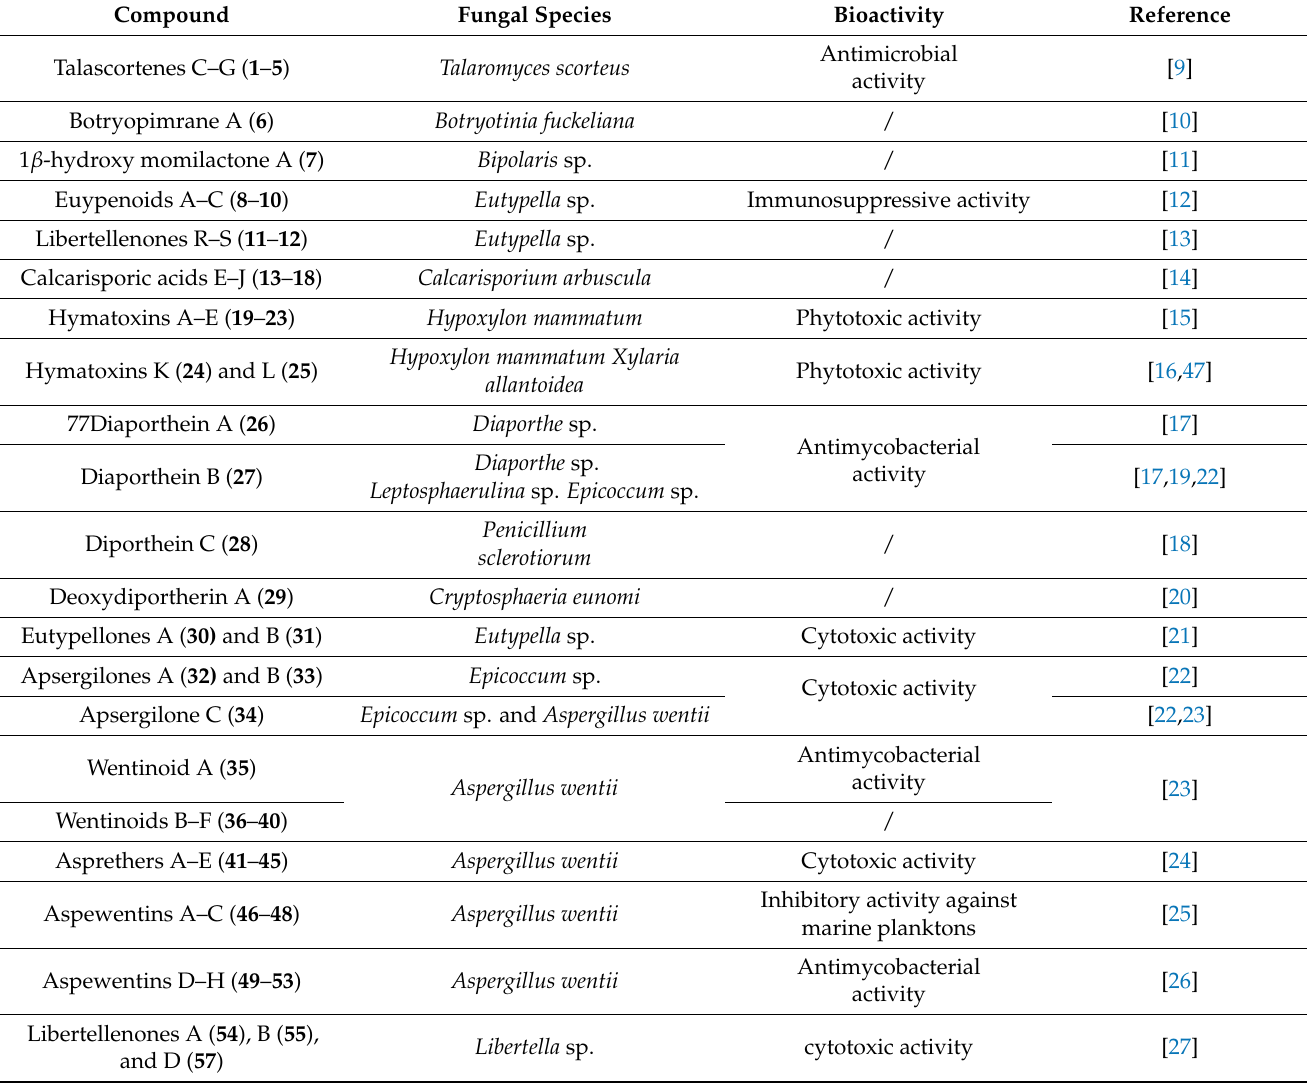
Table 1. Pimarane diterpens from